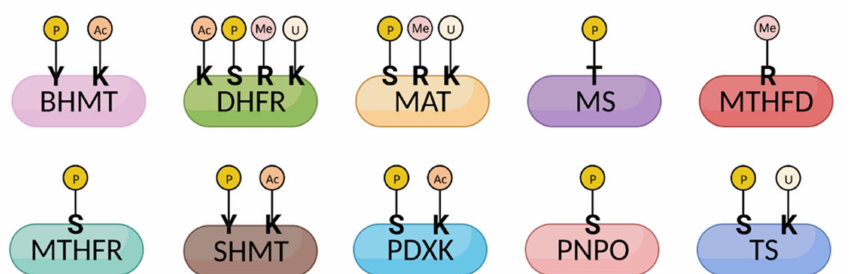
Figure 3. One-carbon enzymes are modified post-translationally. Enzymes involved in the one carbon metabolism pathway undergo a variety of post-translational modifications (PTMs), includ- ing phosphorylation, acetylation, methylation, and ubiquitylation. Several modifications (MTHFR phosphorylation and MTHFD1 methylation) affect protein activity and efficiency, thereby altering one carbon metabolic flux. Since identifying many other PTMs with proteomic screens, the biolog- ical effects of several other PTMs remain undefined. Note that the illustrated modifications only represent a selection of identified PTMs. Y, tyrosine; K, lysine; S, serine; R, arginine; T, threonine. P, phosphorylation; Ac, acetylation; Me, methylation; U, ubiquitylation. Figure made with